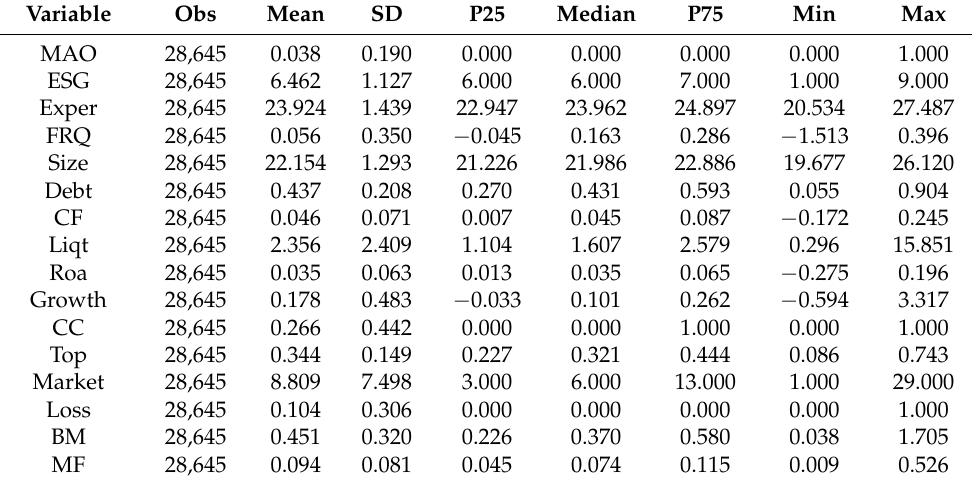
Table 2. Descriptive statistics.